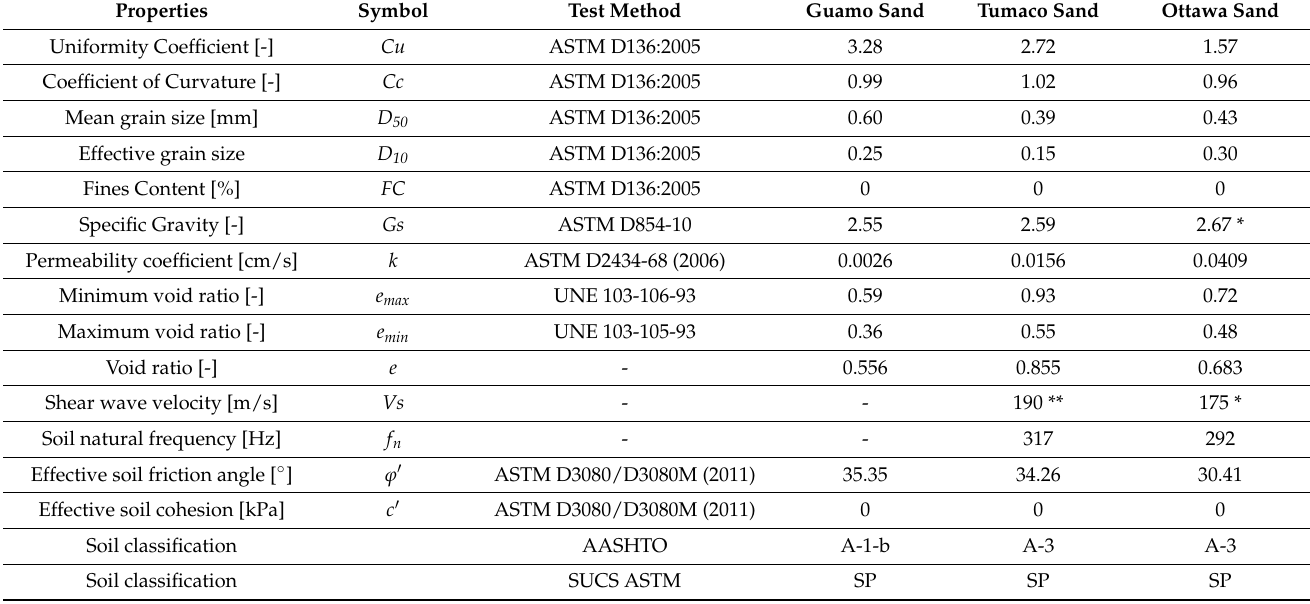
Table 6. Characterization of Guamo, Tumaco, and Ottawa sands used in the